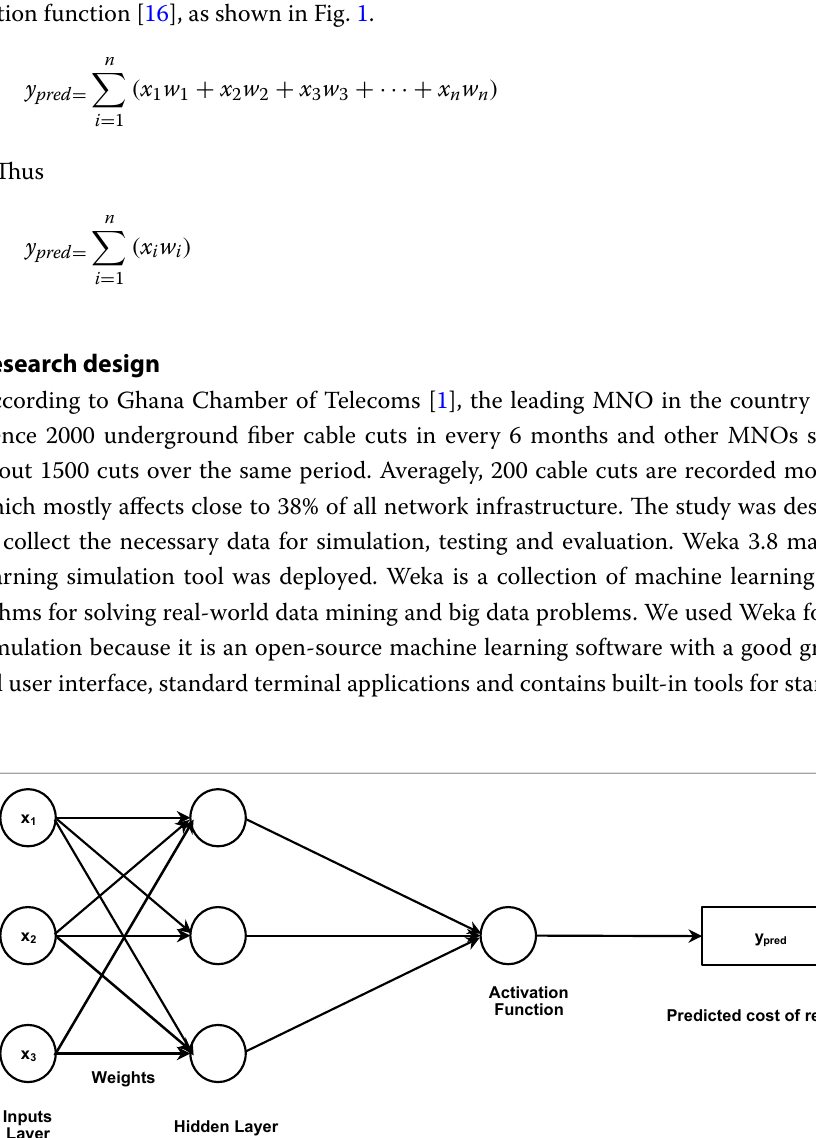
Fig. 1 Multilayer perceptron